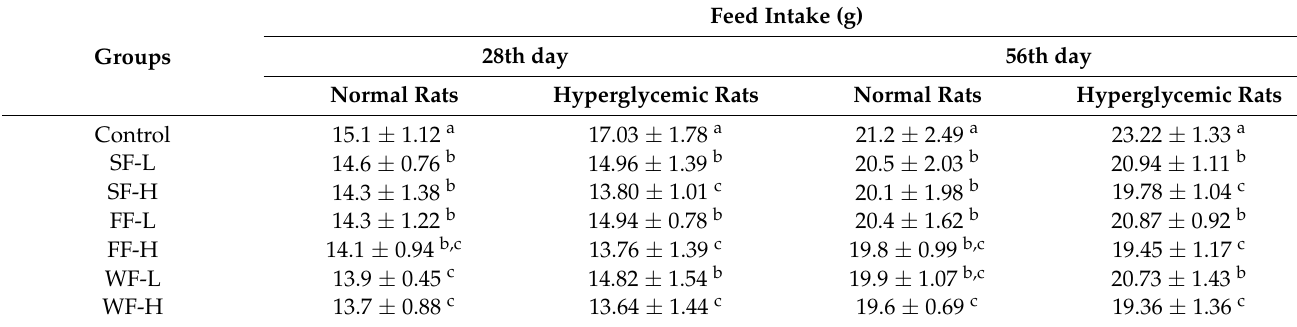
Table 2. Impact of bitter melon supplementation on feed intake of rats.